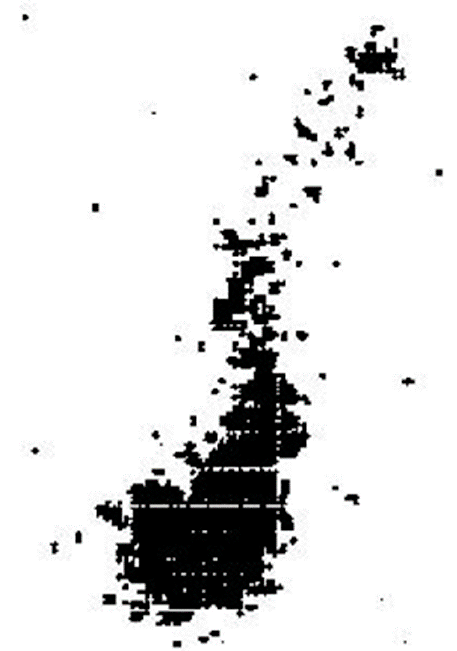
Figure 9. The electron track produced by a 54 keV X-ray as imaged with the optical imaging chamber. The detector gas was a mixture of 2 atmospheres of argon (90%), methane (5%), and trimethylamine (5%). The track is about 14 mm in length. The blob at the top-right is the Auger electron cloud produced by the initial ionization.